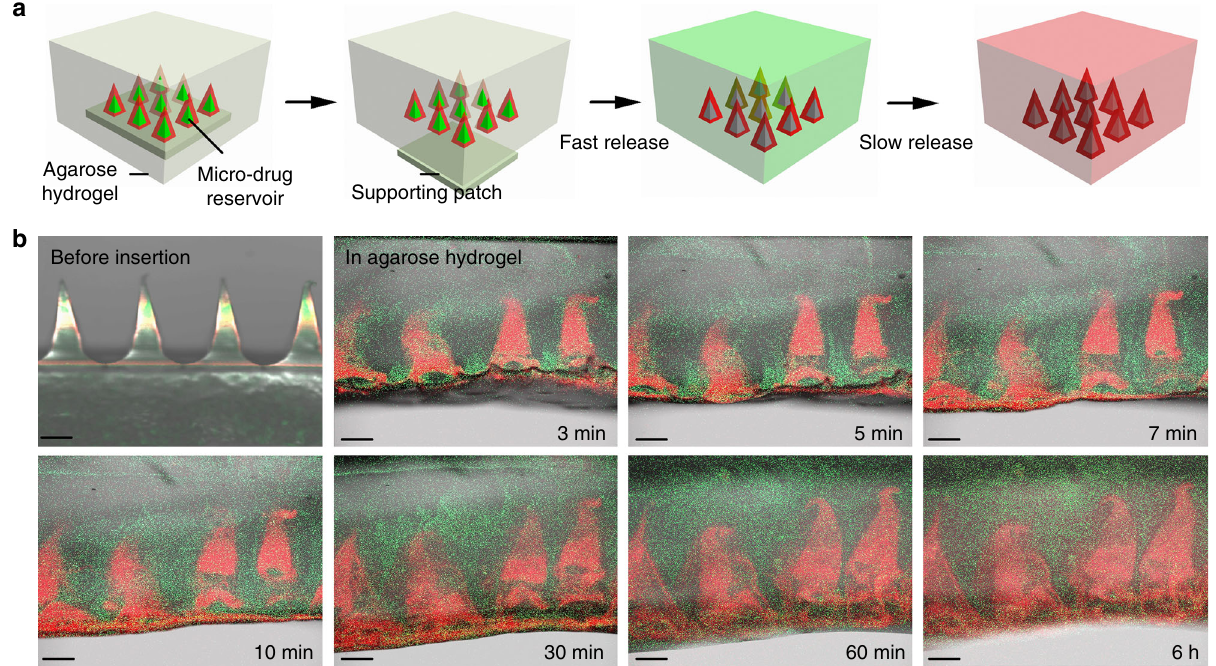
Fig. 4 Biphasic release pro fi le of double-layered microneedles. a Schematic release pro fi le of DL-MNs in agarose hydrogel. b The merge of the optical and fl uorescence image of DL-MNs with the supporting patch (before insertion), and visualization of real-time release of IgG(680) (red colour) and IgG(488) (green colour) from DL-MNs in agarose hydrogel (3 min – 6 h). Scale bars = 200 µ